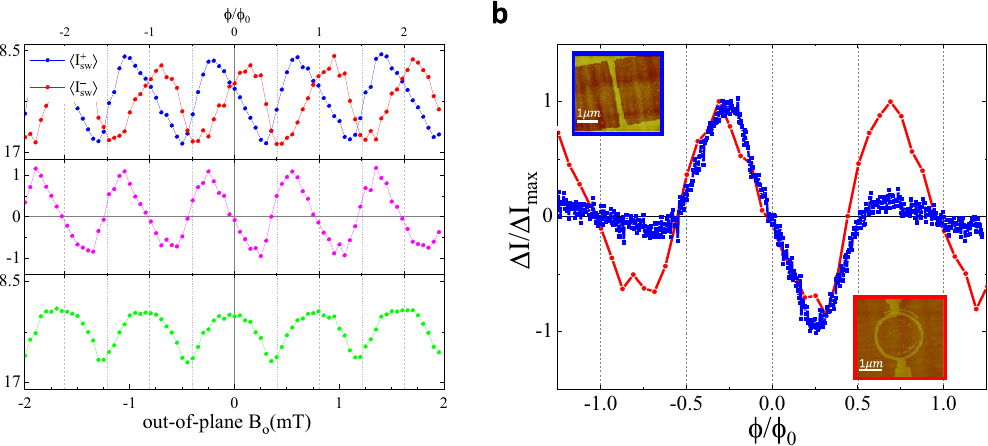
maximalwhile Δ I =0 when the fl ux ϕ = n ϕ 0 . In ( b ) Δ I forthe nanowire and the loop are plotted together as a function of a reduced fl ux ϕ / ϕ 0 , where we used S wire =0.0052 μ m 2 for the effective area in the wire and S loop =2.59 μ m 2 in the loop.